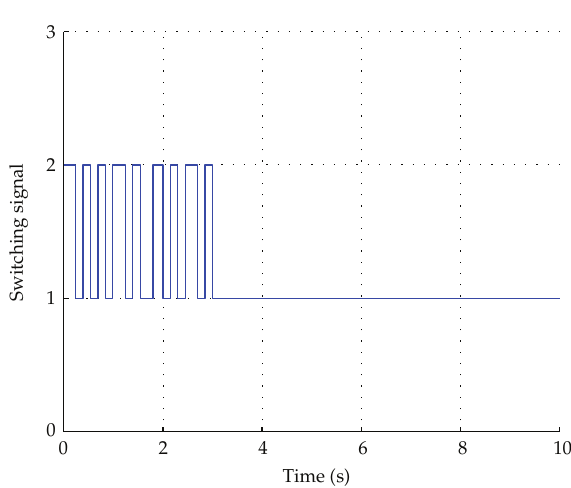
Figure 3: Switching signal with the average dwell time T a > 0 .